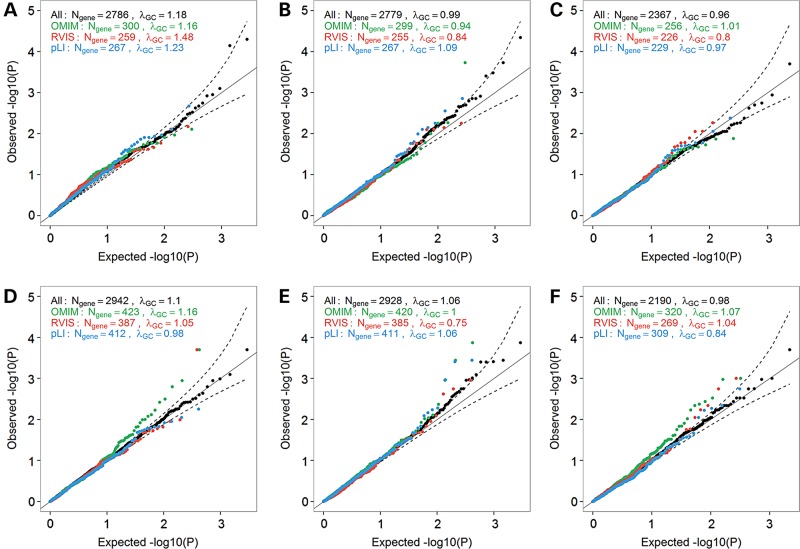
Quantile-quantile (QQ) plots of association results between predicted gene knockouts (KOs) in candidate-genes and anthropometric traits. We restricted these analyses to OMIM disease-causing genes (green), genes with Residual Variation Intolerance Score (RVIS) score <15% of RVIS scores for all genes in the human genome (red), or genes with a probability of being loss-of-function intolerant (pLI) score >0.9 (blue). We report results for three anthropometric traits in the NHLBI Exome Sequence Project (ESP): (A) body mass index (BMI) (Nparticipants = 4475), (B) height (Nparticipants = 4423) and (C) waist-to-hip ratio (WHR) (Nparticipants = 2973). We also report results for the same traits in the GIANT ExomeChip datasets: (D) BMI (Nparticipants = 103 838), (E) height (Nparticipants = 102 775), and (F) WHR (Nparticipants = 62 355). Results are not corrected for the genomic inflation factor. The dash lines correspond to the 95% confidence interval. λGC, genomic inflation factor; Ngene, number of genes with at least one participant that carries two LoF alleles.